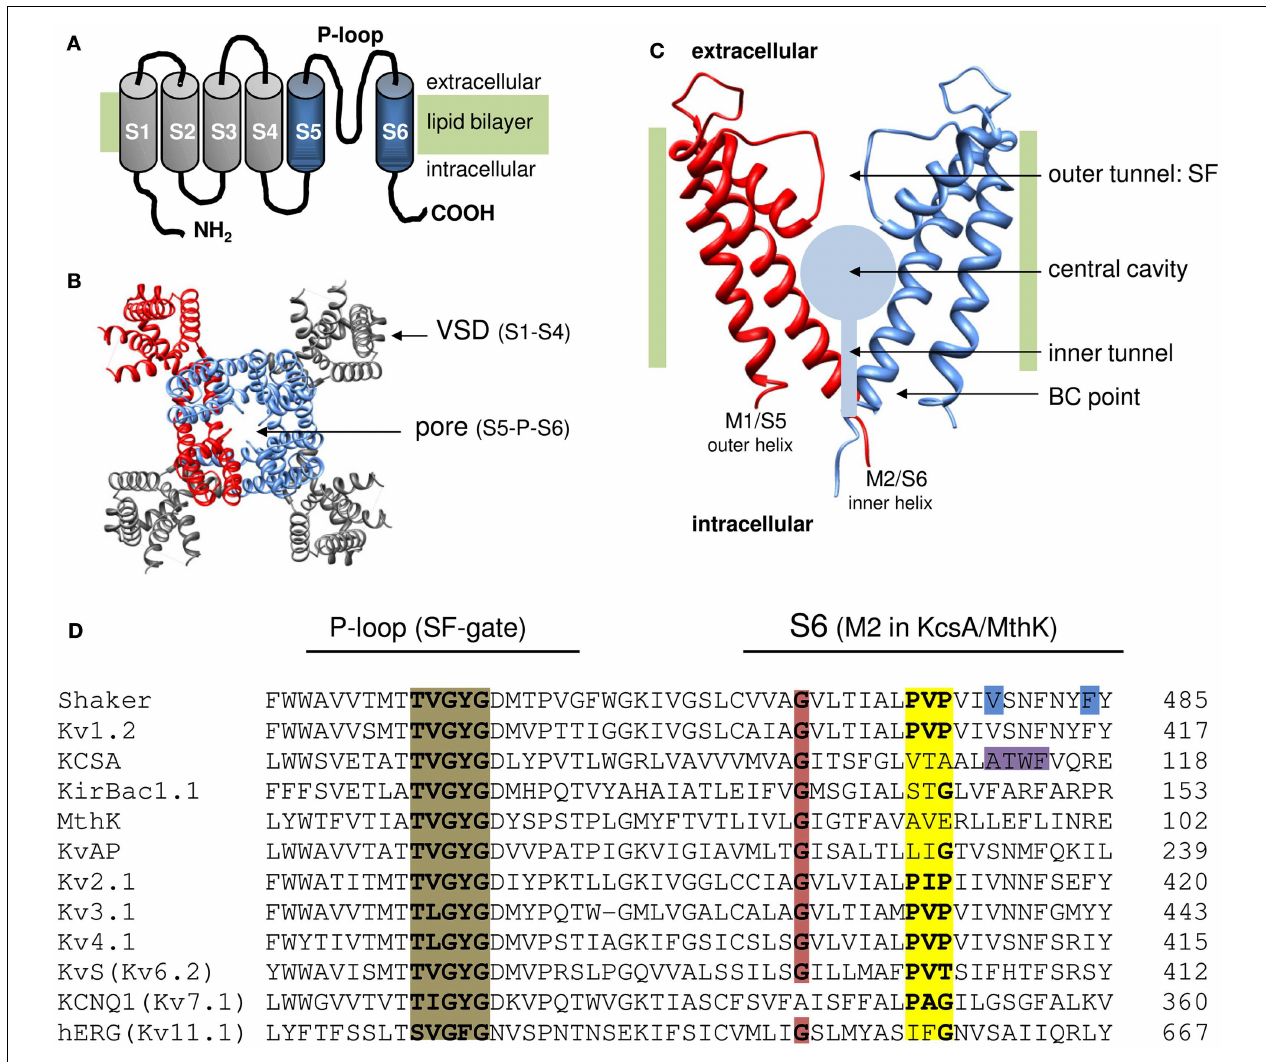
side – can be divided in three recognizable sections; (1) a water filled inner tunnel, (2) a wider 12Å in diameter water filled cavity, and (3) a narrower outer tunnel that forms the ion selectivity filter (SF) that dictates K + selectivity. Both the inner tunnel and the central cavity are formed by the inner pore helices that cross the membrane under an angle of ∼ 25˚ making the resemblance with an inverted teepee (Doyle et al., 1998).The K + pathway contains two energy barriers for K + that function as a gate: (1) at the bundle crossing (BC) of the M2/S6 helices (BC gate) that forms a barrier for hydrated K + and (2) the SF that allows passage of K + ions which have shed their hydration shell. (D) Sequence alignment of the inner pore helix of the pore module (S6 and M2 segment, respectively), and the P-loop that forms the channels SF which contains theTVGYGD signature sequence (highlighted in brown) for a K + selective channel (Heginbotham et al., 1994). Highlighted in red is the highly conserved glycine residue in the middle of the inner pore helix.The PXP motif present in Kv channels is highlighted in yellow. Note that in the “silent” Kv channels (KvS, with the Kv6.2 member represented) the second proline of the PXP motif is lacking.The residues proposed to seal off the K + pore in Shaker (gate residuesV478 and F484) are highlighted in blue and the residues at the level of the BC in KcsA are highlighted in